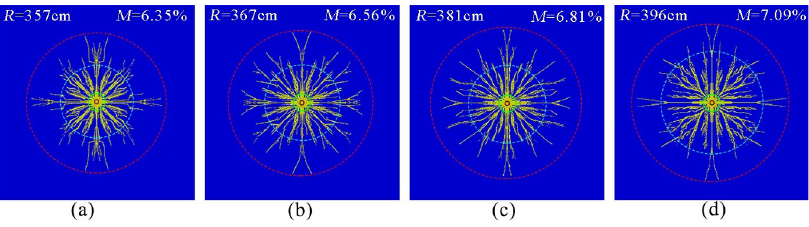
Fig 9. Crack distribution at different compressive strengths. (a)Compressive strength 20 MPa.(b)Compressive strength 16 MPa.(c)Compressive strength 12 MPa.(d)Compressive strength 8 MPa.